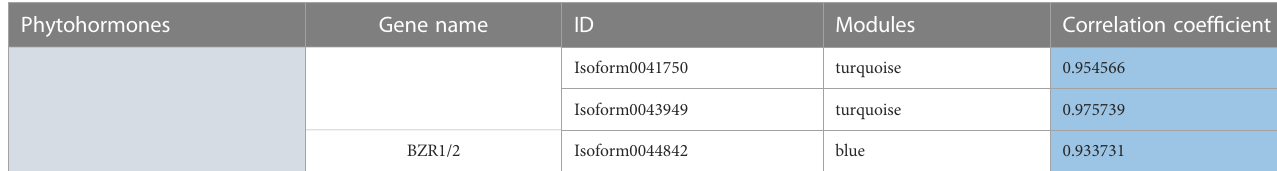
The abbreviations of gene names in the table as follow: PYL, abscisic acid receptor PYR/PYL family; SnRK2, subfamily 2 SNF1-related kinases; IAA, auxin-responsive protein IAA; ARF, auxin response factor; SAUR, small auxin up-regulated RNA; MMK1, MAPK KINASE1; DELLA, DELLA protein; PIF, phytochrome-interacting factor; NPR, regulatory protein NPR; AHK, Arabidopsis